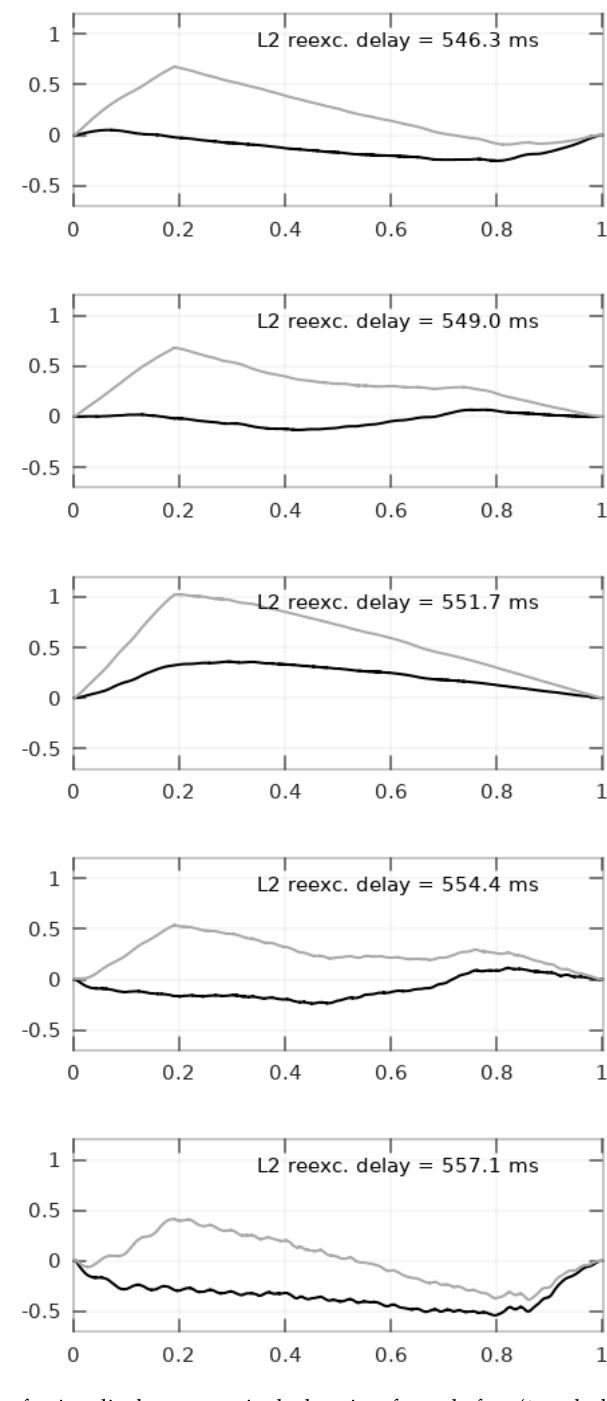
Figure 6. Simulation L2—visualisation of string displacement u in the last time frame before ( t B —dark plot) and the first time frame after the re-excitation ( t A